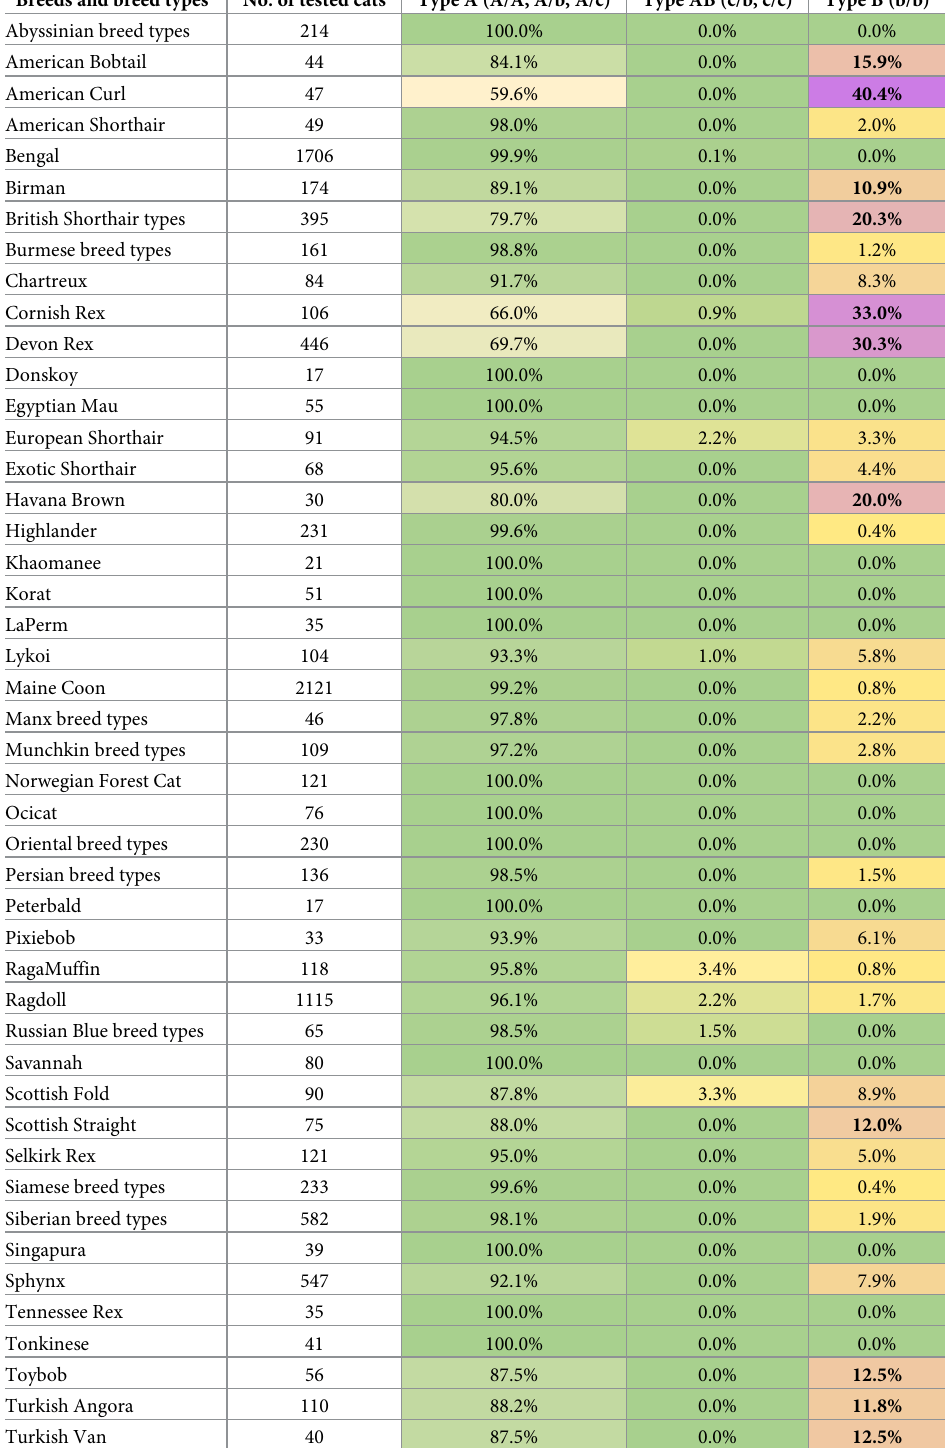
Table 3. Genetically determined proportions of type A, type B and type AB blood for each breed or breed type with > 15 individuals tested. Breeds and breed